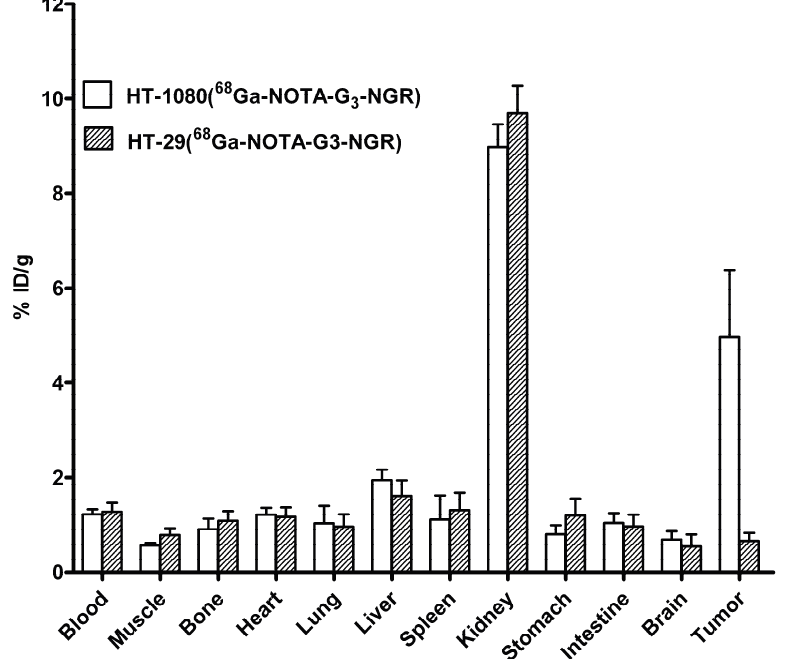
Figure 5. Decay-corrected biodistribution at 1 h post-injectioin of 68 Ga-NOTA-G peptide in HT-1080 and HT-29 tumor